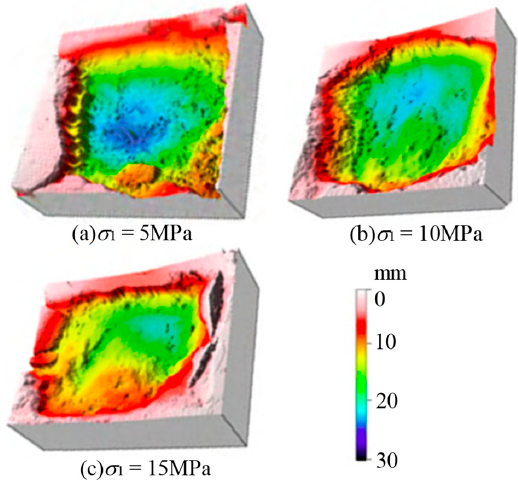
Figure 7. Variations of fractured surface with increase of σ 1 while σ 2 is constant at 25